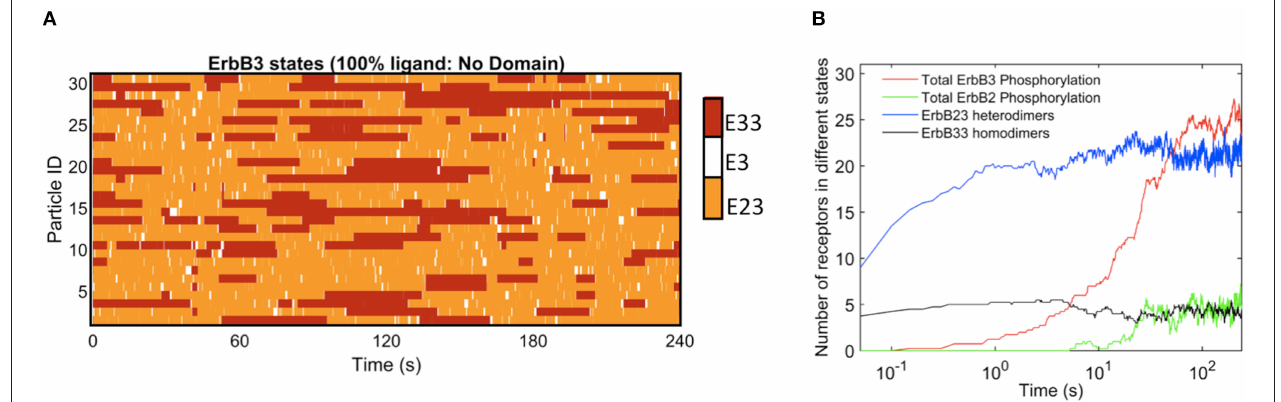
FIGURE 2 | Kinetics of ErbB3 dimerization and phosphorylation. (A) Representative plot of individual ErbB3 receptors showing changes in receptor state over time. ErbB3 receptors cycle between homodimer, heterodimer and monomer states. (B) Plot showing the kinetics of dimer formation and phosphorylation of ErbB2 and ErbB3. ErbB2/3 heterodimer and ErbB3/3 homodimer formation are plotted with total ErbB2 and ErbB3phosphorylation over time for 100% ligand in the absence of domains. Data in B are the averages of 4